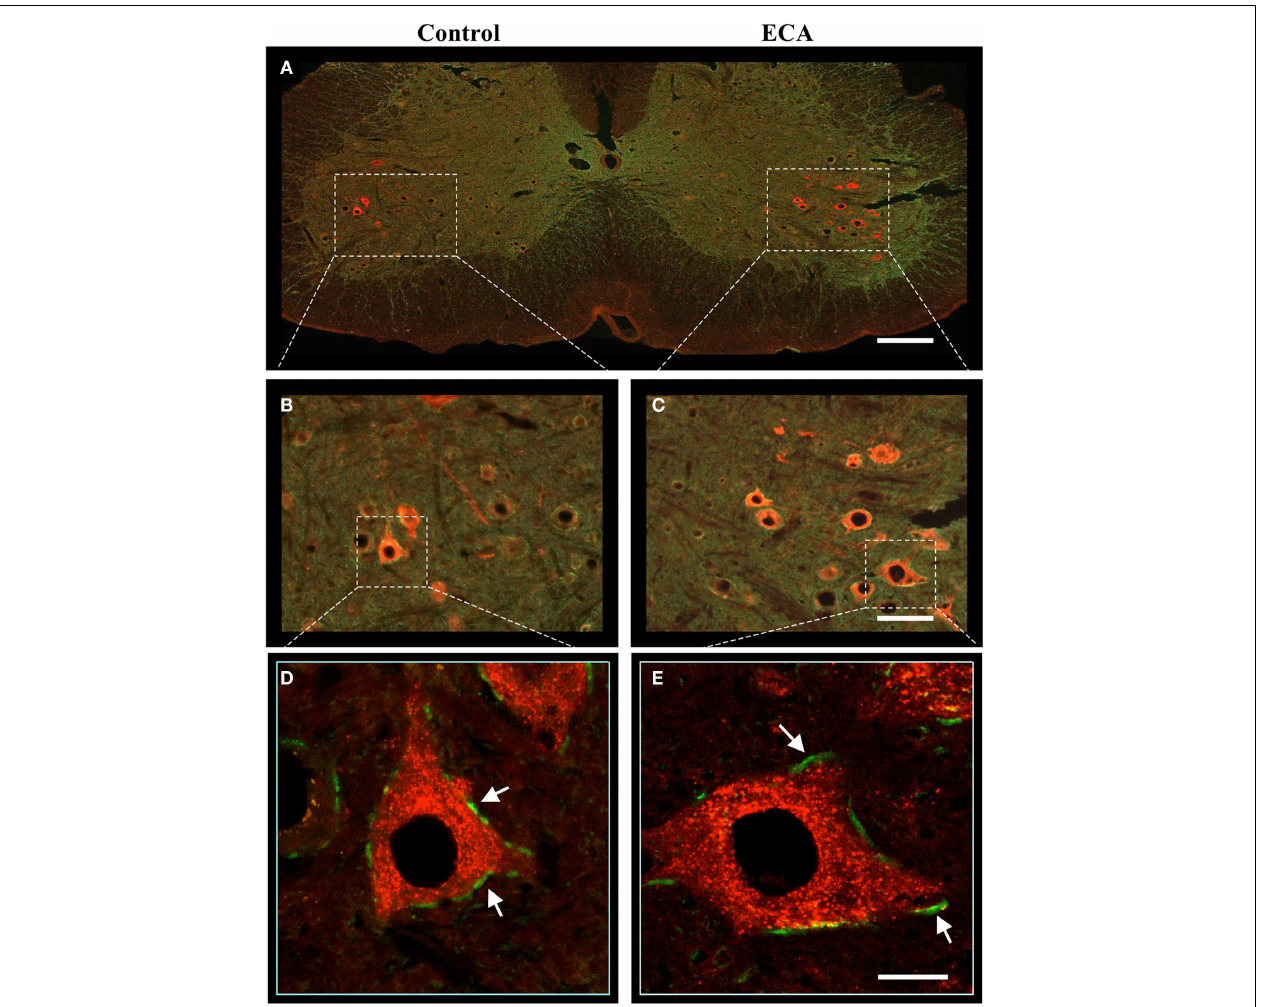
images (D,E) showing contacts (arrows) between synaptophysin immuno-labeled structures (displayed in green) along the membrane of the RLMs (displayed in red). Immunoreactivity for synaptophysin in the assessed area was consistently reduced in injured motoneurons but did not reveal any significant difference between the two repair methods. Scale bar (A) = 250 μ m, (B,C) = 100 μ m, (D,E) = 25 μ m.